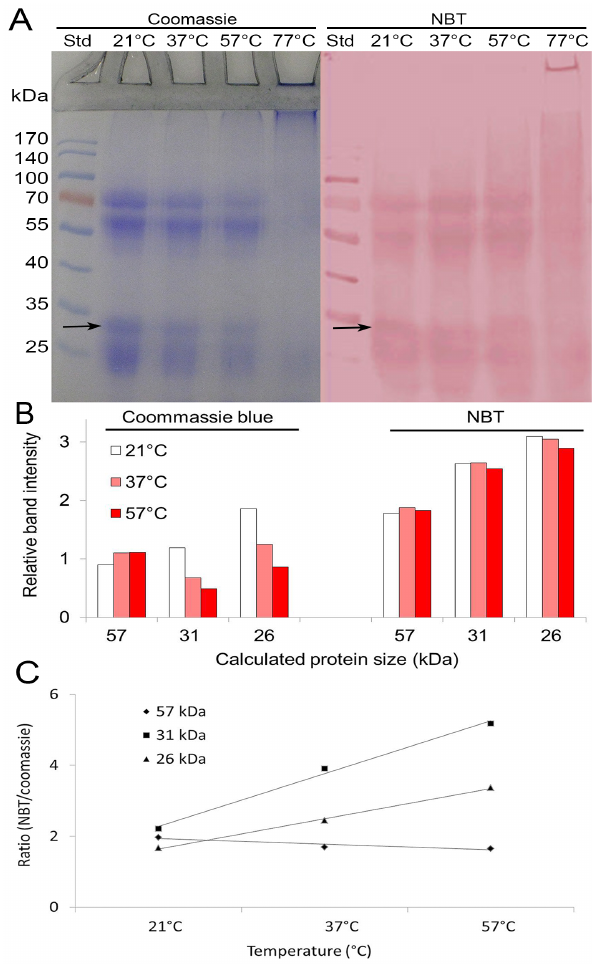
Figure 6. Quinone binding by 31 kDa protein is temperature- dependent. The effect of the accelerated aging of honey H177 on the content of the 31 kDa protein as evidenced by the Coomassie blue- stained SDS gels and on its interaction with quinones, as evidenced by the NBT staining of the blots (A). The arrow indicates a position of the 31 kDa protein. A semi-quantitative representation of these changes in the Coomassie stained SDS gels and in the NBT stained blots (B). The aging -dependent increase in quinone- 31 kDa protein binding visualized as a relative ratio of the NBT/Coomassie staining (C).